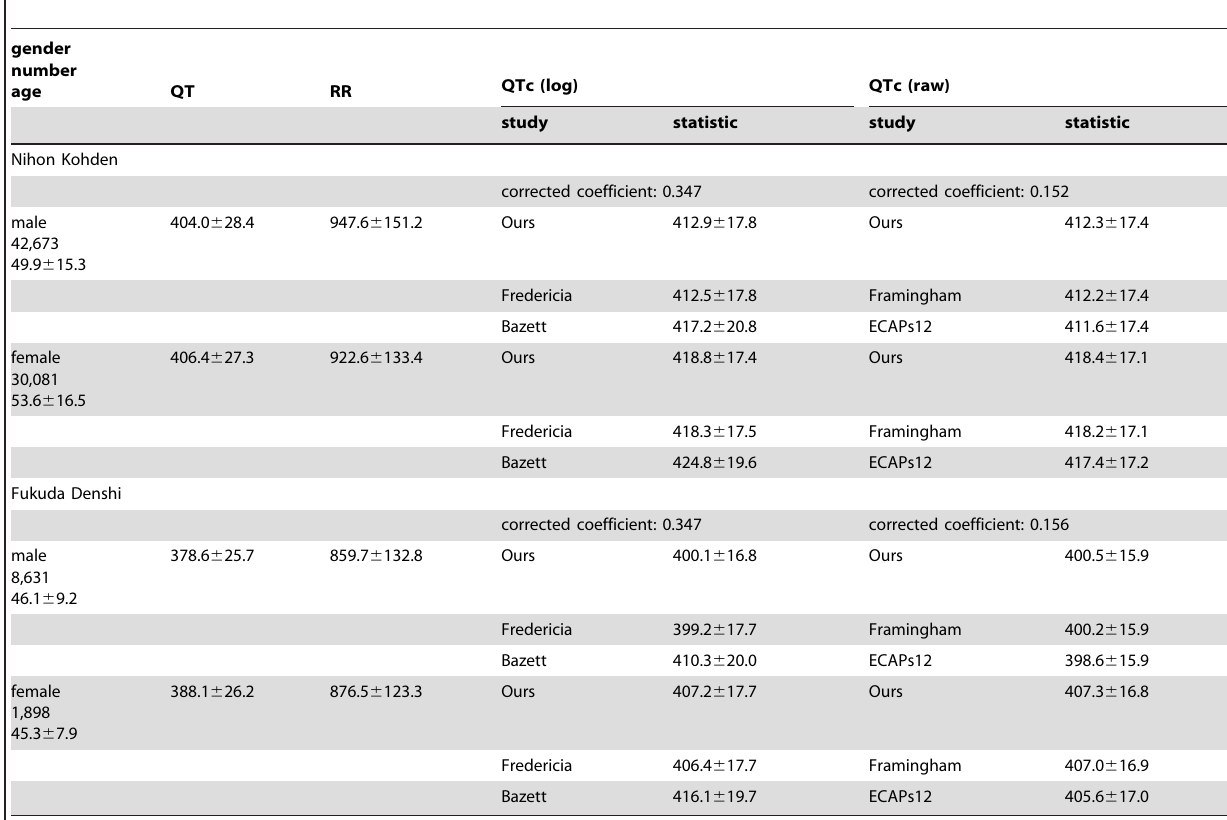
Table 1. Comparison of automatic QT measurements in adult resting ECGs between Fukuda Denshi and Nihon Kohden.